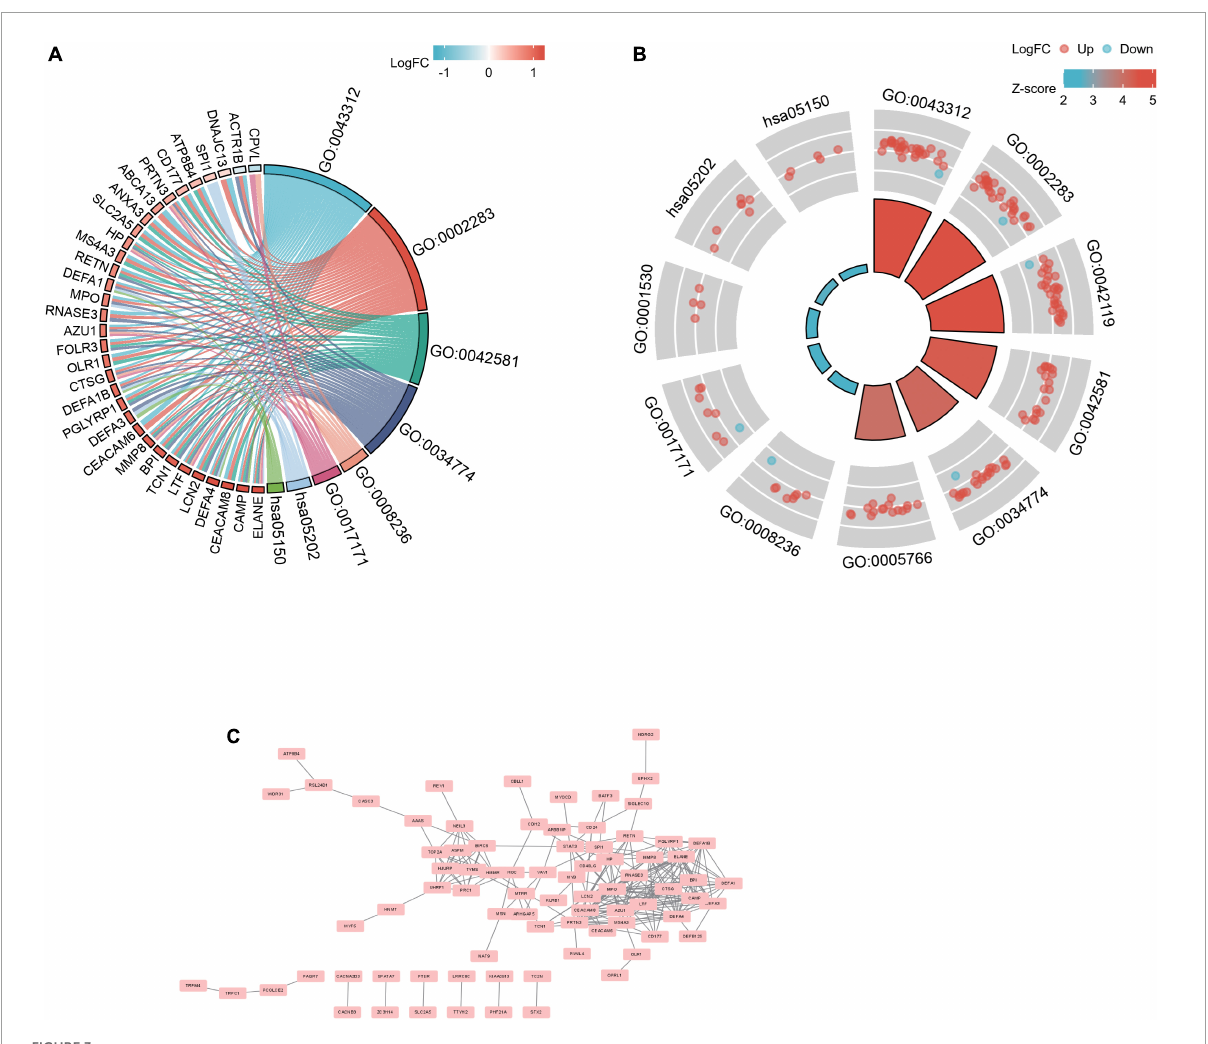
FIGURE3 PPI network and functional enrichment of DEGs. The enrichment analysis results of GO and KEGG pathway [ (A) : chordal graph; and (B) : loop graph]. Adjusted P value < 0.05 was considered significant. (C) The interaction network between proteins coded by DEGs.